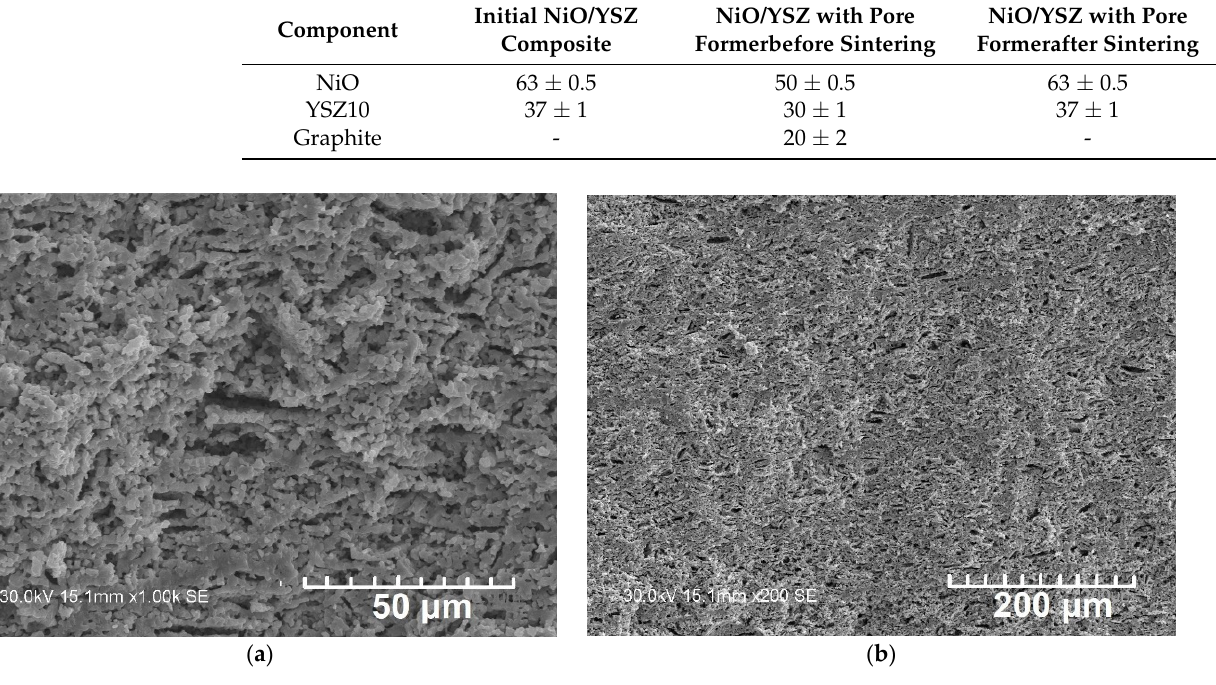
Figure 12. Images of cross sections of the sintered NiO/YSZ-based anode in the presence of graphite; 2000 ( a ) and 200 ( b ) times magnification.